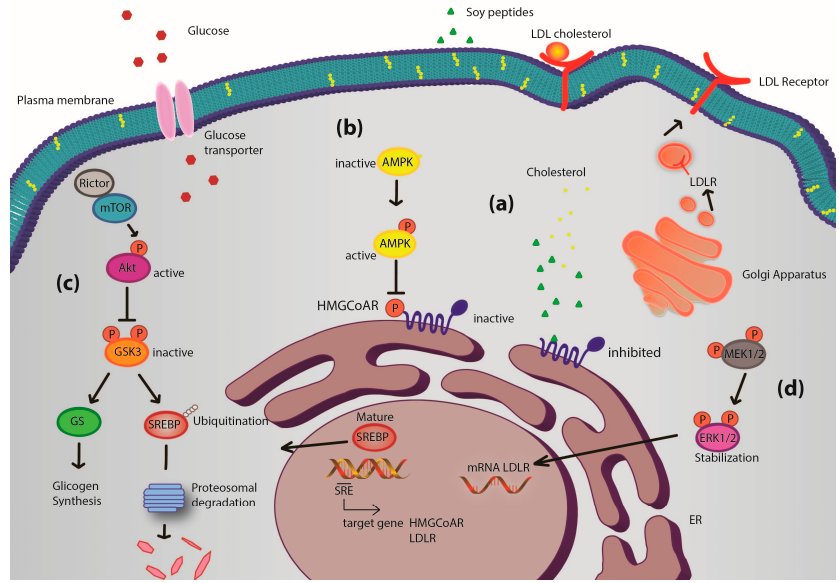
Figure 4. Potential mechanism of action of soy peptides in HepG2 cells. Upon cell penetration, they act as competitive inhibitors of 3-hydroxy-3-methylglutaryl CoA reductase (HMGCoAR) leading to an intracellular cholesterol synthesis reduction. The consequence is the activation of the transcription factor sterol regulatory element-binding proteins (SREBP) 2, which leads to low density lipoprotein receptor (LDLR) and HMGCoAR genes transcription, with subsequent increase of LDLR and HMGCoAR protein levels and LDLR localization in plasma membrane ( a ); In parallel, soy peptides reduce cholesterol production also by activation of the monophosphate-activated protein kinase (AMPK) pathway through an increase of phosphorylation at Thr-172, which in turn inactivates its target substrate HMGCoAR through phosphorylation at serine-872 and produces an increase of the activity of glucose transporters ( b ); IAVPGEVA, IAVPTGVA and LPYP enhance Akt activation, through an increase of phosphorylation at Ser473, which in turn inactivates glycogen synthase kinase 3 αβ (GSK3 αβ ), a kinase that contributes to proteasomal degradation of SREBP2 [10,28,29]. Moreover, GSK3 αβ , inactivated by Akt phosphorylation at Ser21/9, does not inhibit glycogen synthase (its substrate) that can convert the increased up-taken glucose in intracellular glycogen ( c ); Finally, extracellular-signal-regulated kinases (ERK) 1/2 pathway activation [10] could lead to stabilization of mRNA levels of LDLR contributing to increase LDLR protein levels in plasma membrane ( d ). Thus, the distinct modulation of four pathways leads to an increased LDLR activity, which can bind and carry extracellular LDL in HepG2 cells with final hypocholesterolemic effects. Moreover, Akt and AMPK pathway activations are correlated with glucose metabolism modulation, which leads to an increase of glucose-uptake by human hepatic cells.